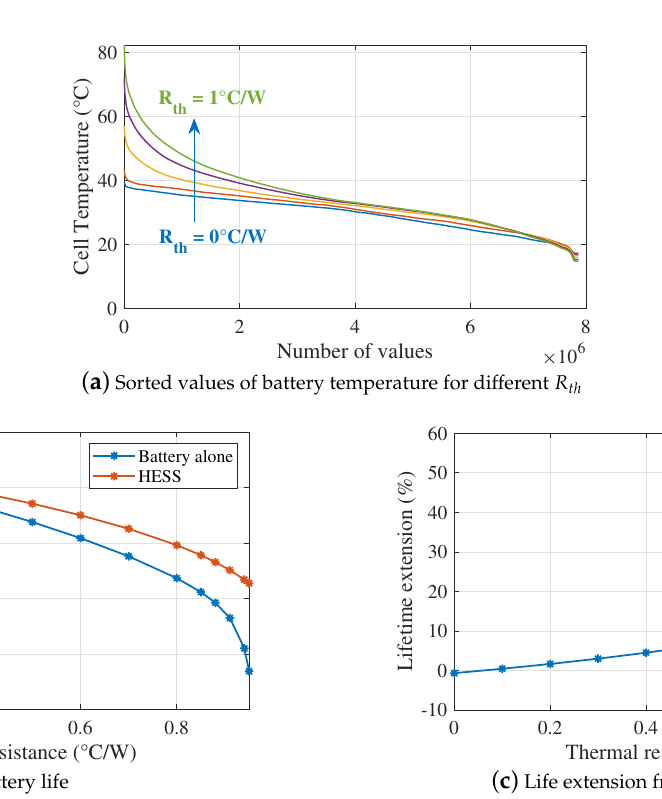
( c ) Life extension from hybridization Figure 15. Thermal resistance’s effect on battery